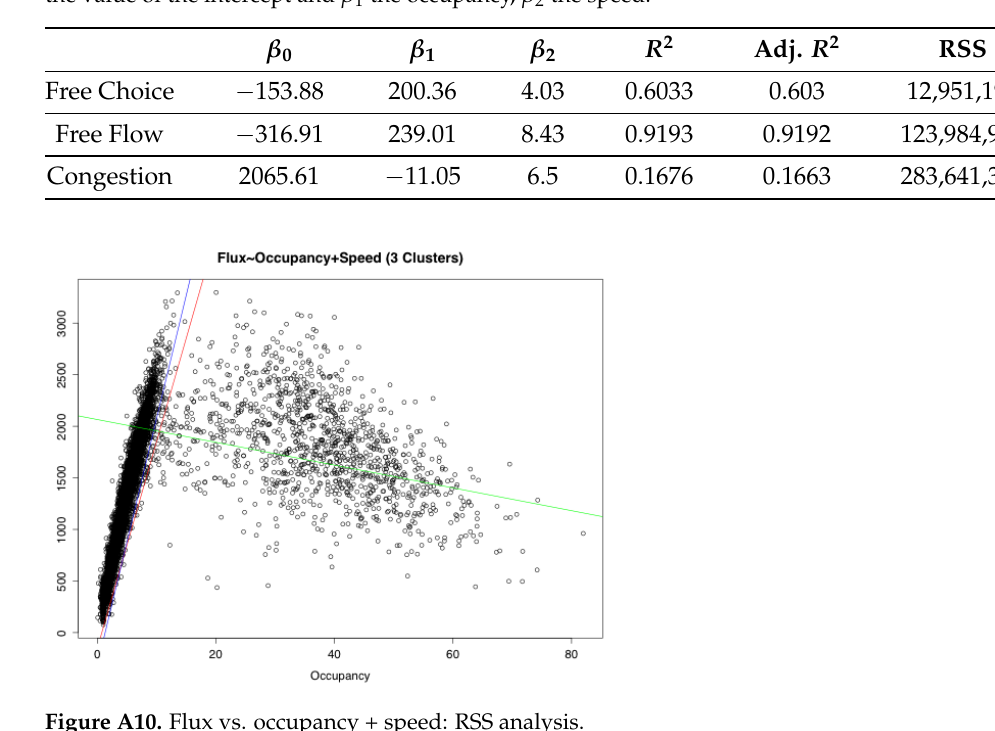
Figure A9. Flux vs. occupancy: RSS analysis. Table A5. Residual sum squared analysis with three clusters with flux, occupancy and speed. β 0 is